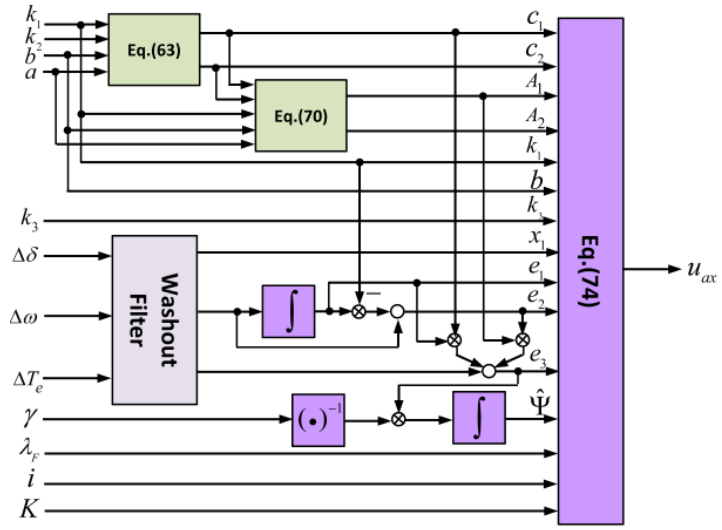
Figure 8. Realization of proposed controller of AC side.